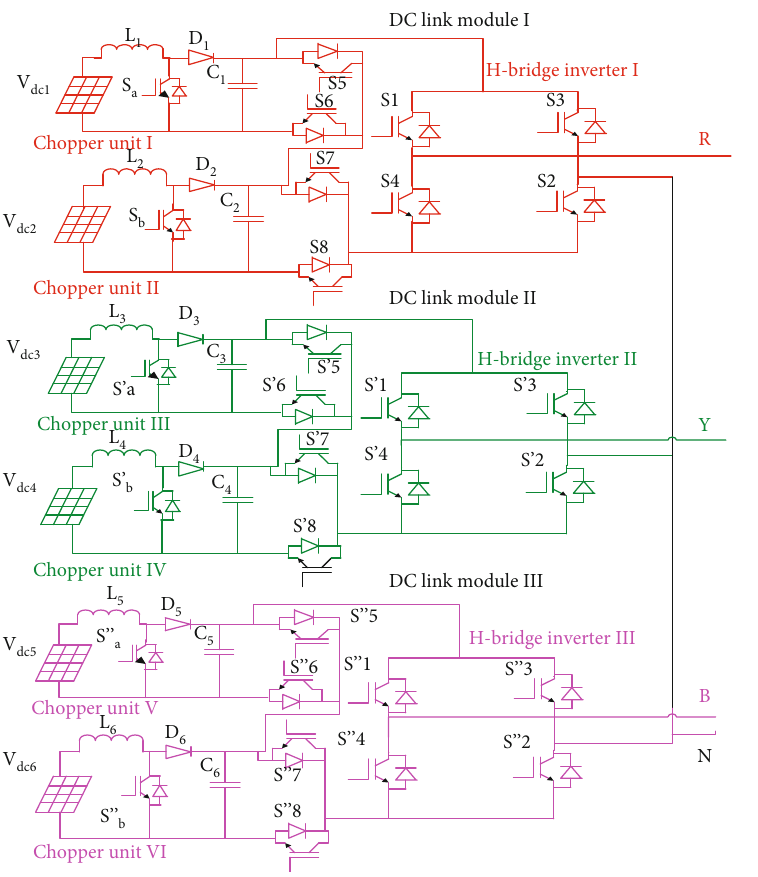
Figure 2: Equivalent circuit of three-phase seven-level